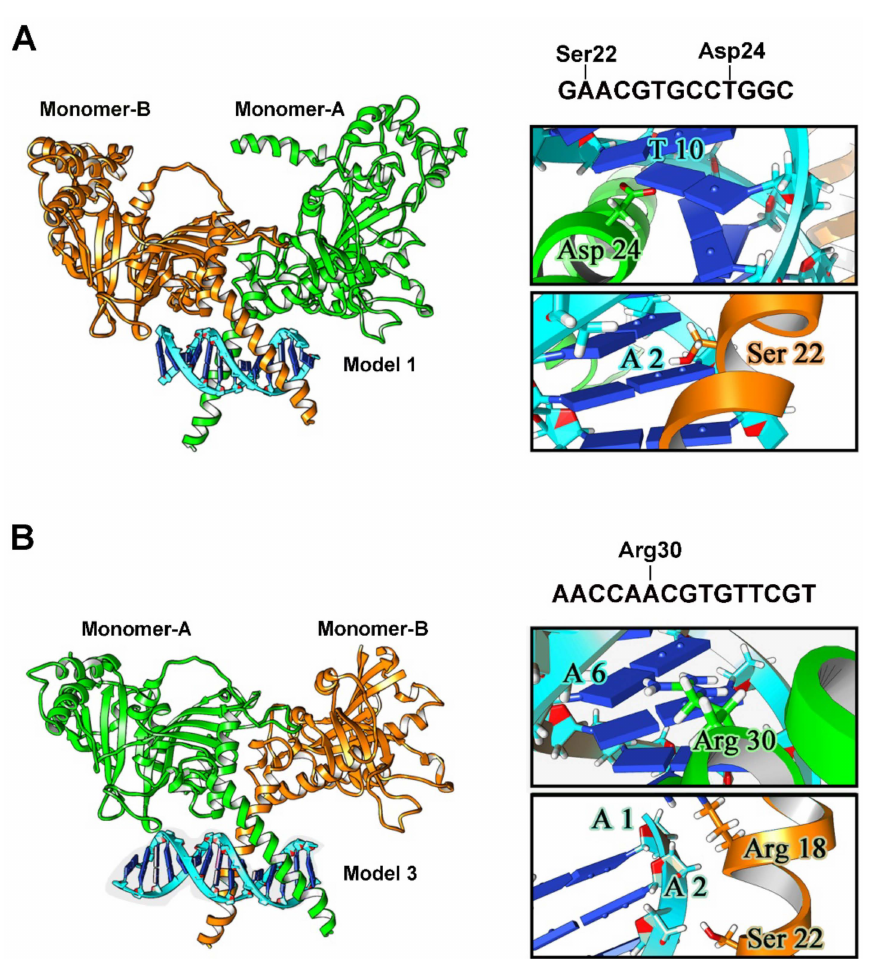
Figure 6. Docking analysis of model 1 and model 3. ( A ) HIF-1/HBS #1 best association complex: full structure and focus on HIF-1-DNA interactions (boxes). ( B ) HIF-1/HBS #3 best association complex: full structure and focus on HIF-1-DNA interactions